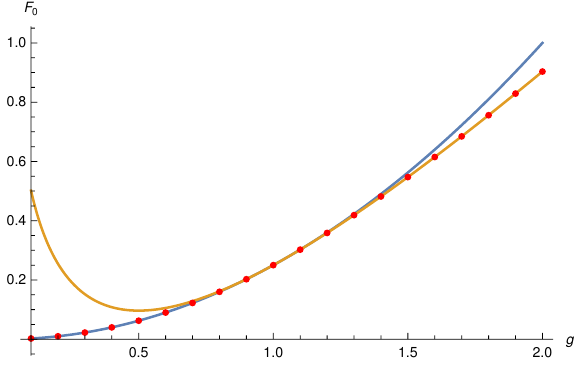
Figure 1. Plot of the genus-zero free energy F 0 ( g ). The red dots are the exact value of the free energy 1 log Z ( N; g ) for N = 100, while the blue curve and the orange curve represent the analytic N 2 form of F 0 ( g ) in (2.7) in the ungapped phase and the gapped phase, respectively.